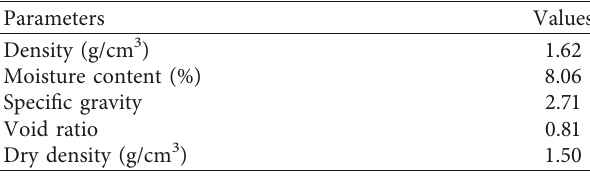
Table 1: Properties of the soil